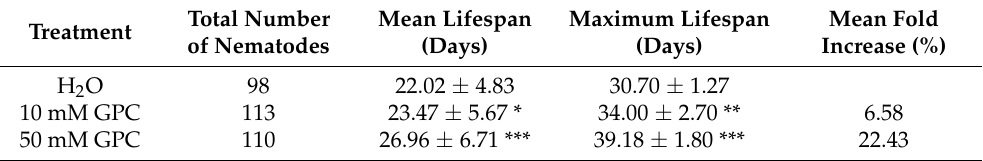
Table 1. Effect of GPC on the lifespan of C. elegans .